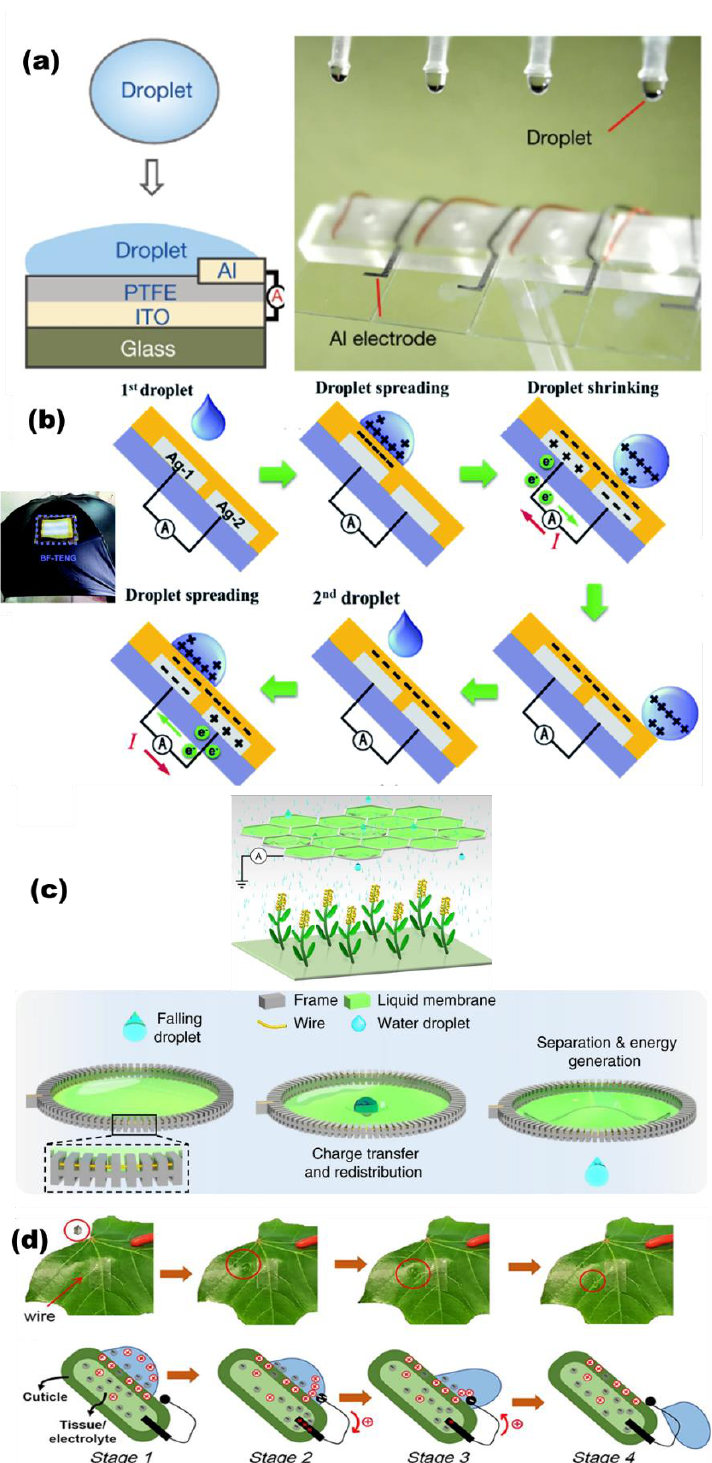
Figure 8. ( a ) The schematic diagram of DEG device (reproduced with permission from [55]. Copyright 2020 Springer Nature, Berlin, Germany). ( b ) The electrification mechanism of water droplets falling on an inclined BF-TENG (reproduced with permission from [107]. Copyright 2020 Royal Society of Chemistry, London, UK). ( c ) The working principle and schematic diagram of L–L TENG collects energy from raindrops in an irrigation system (reproduced with permission from [56]. Copyright 2019 Springer Nature, Berlin, Germany). ( d ) Schematic of the working mechanism of the FBD-TENG (reproduced with permission from [28]. Copyright 2020 American Chemical Society, New York, NY,